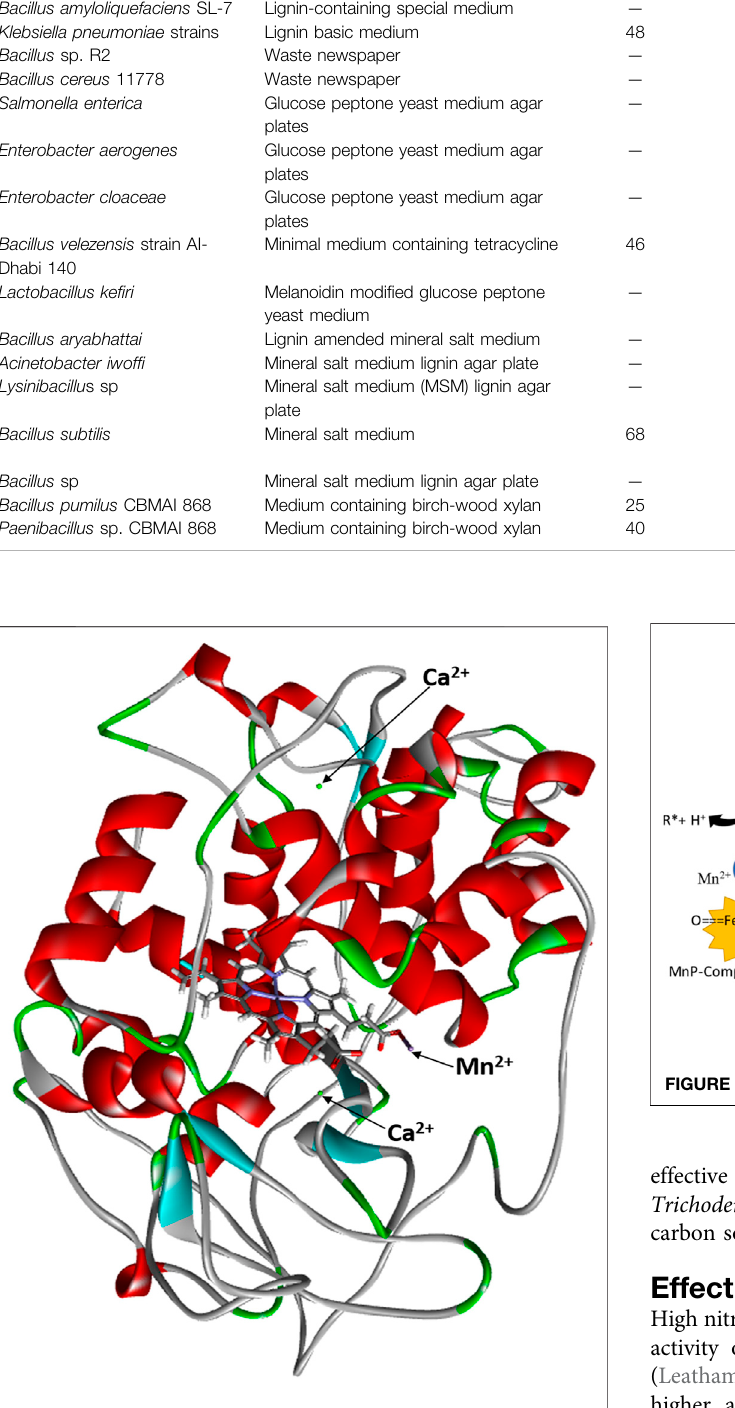
FIGURE 1 | Crystal structure of MnP complexed with Mn 2+ (Sundaramoorthy et al., 2010).